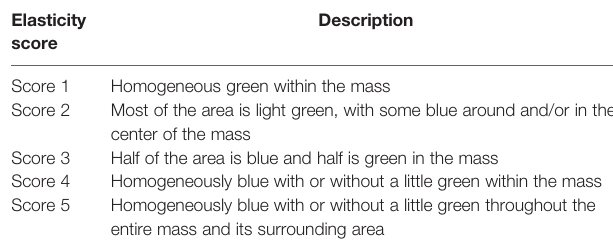
TABLE 1 | The elastic scoring criteria of breast